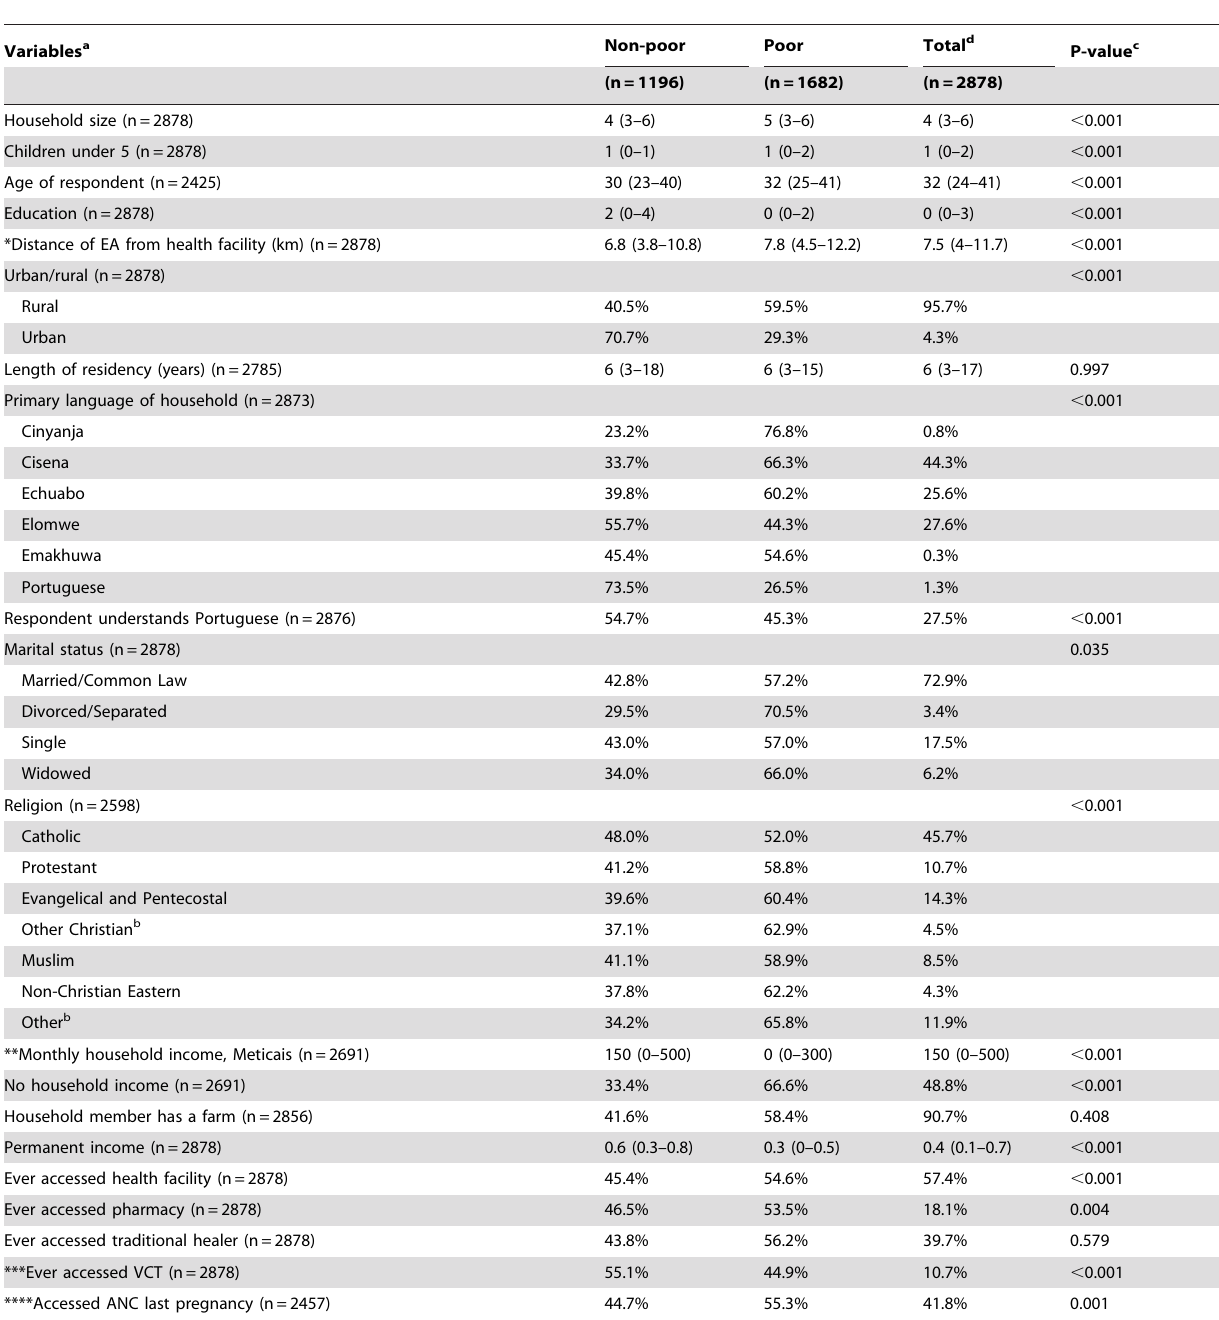
Table 4. Respondent and Household Characteristics by Multidimensional Poverty Status, Ogumaniha